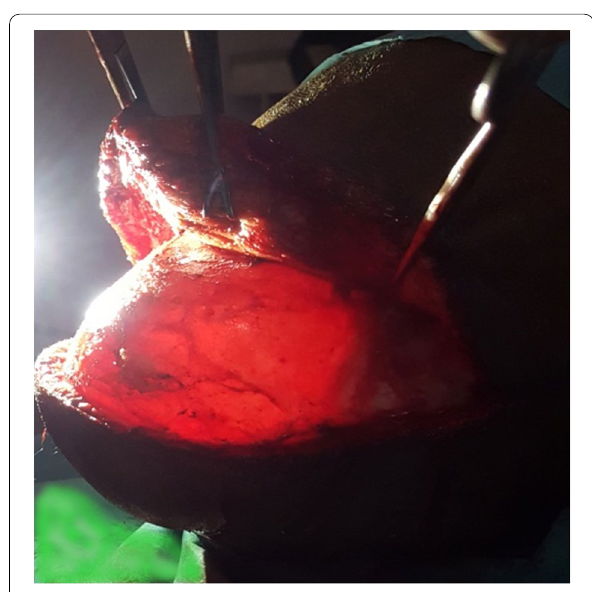
Fig. 4 Operative findings: trans-illuminating cystic lesion of the scalp upon skin